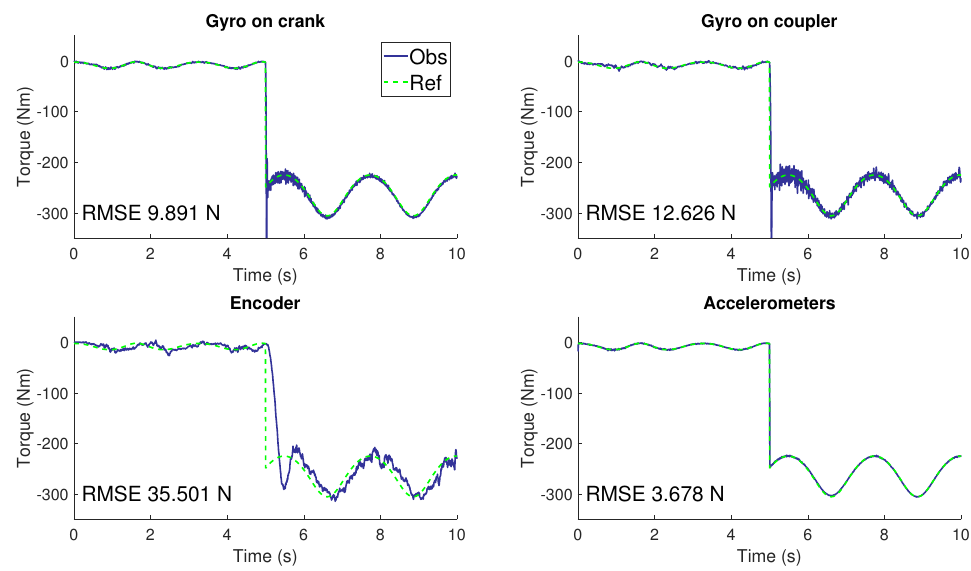
Figure 15. Torque estimation for the four-bar linkage for the spring failure scenario. Obs refers to the estimated torque and Ref refers to the theoretical